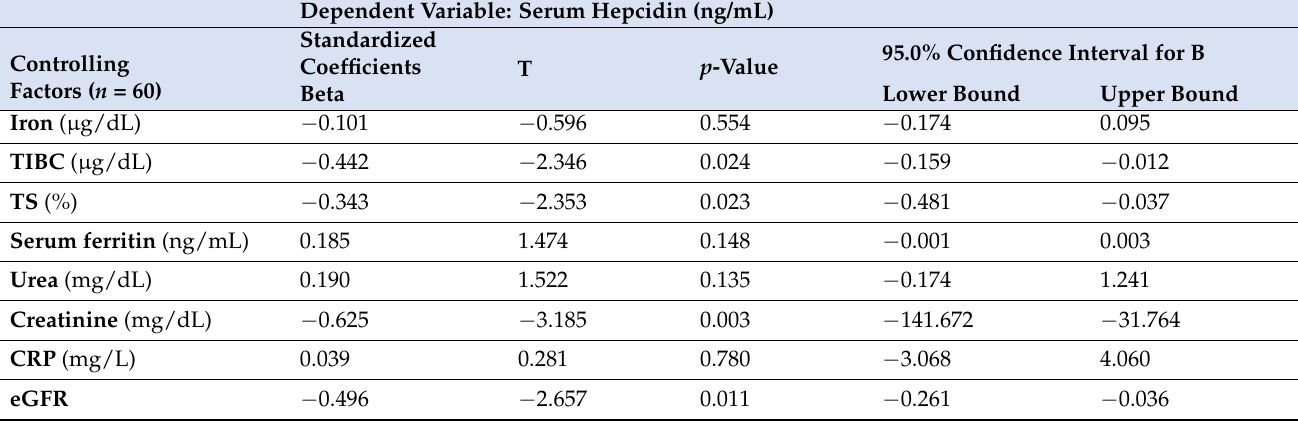
Table 3. Role of eGFR, renal function parameters, and iron status on serum hepcidin level in patients with β -thalassemia